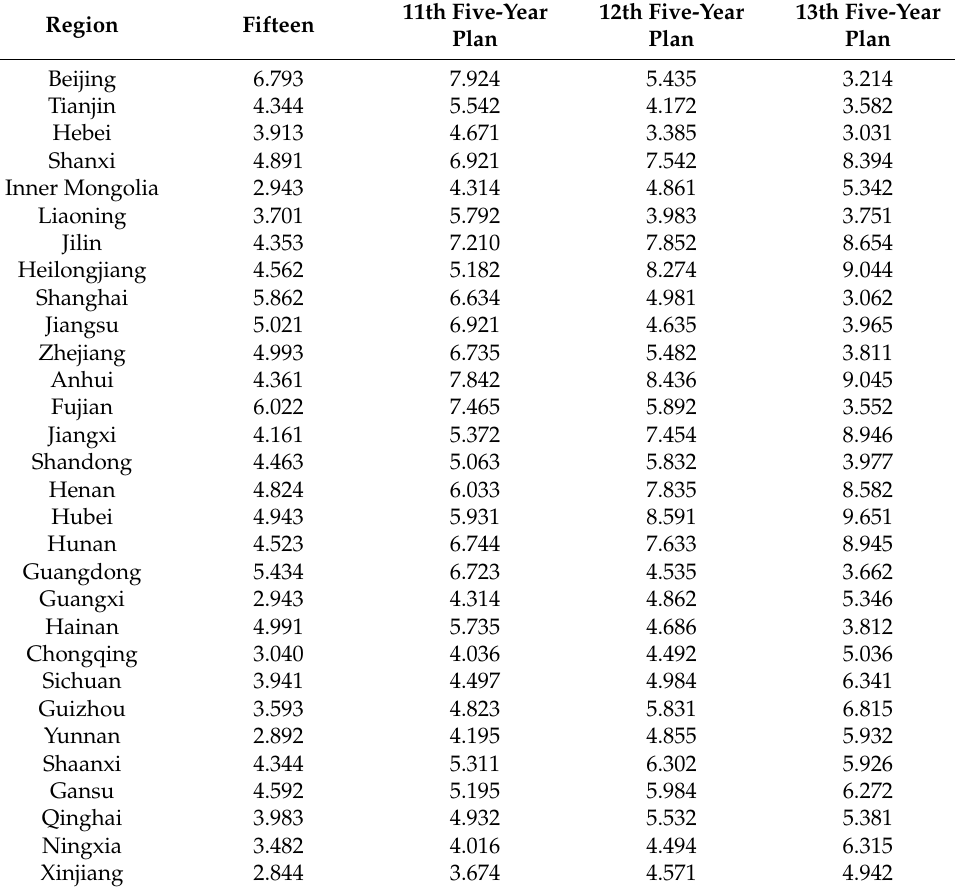
Table 5. Land element’s contribution to economic